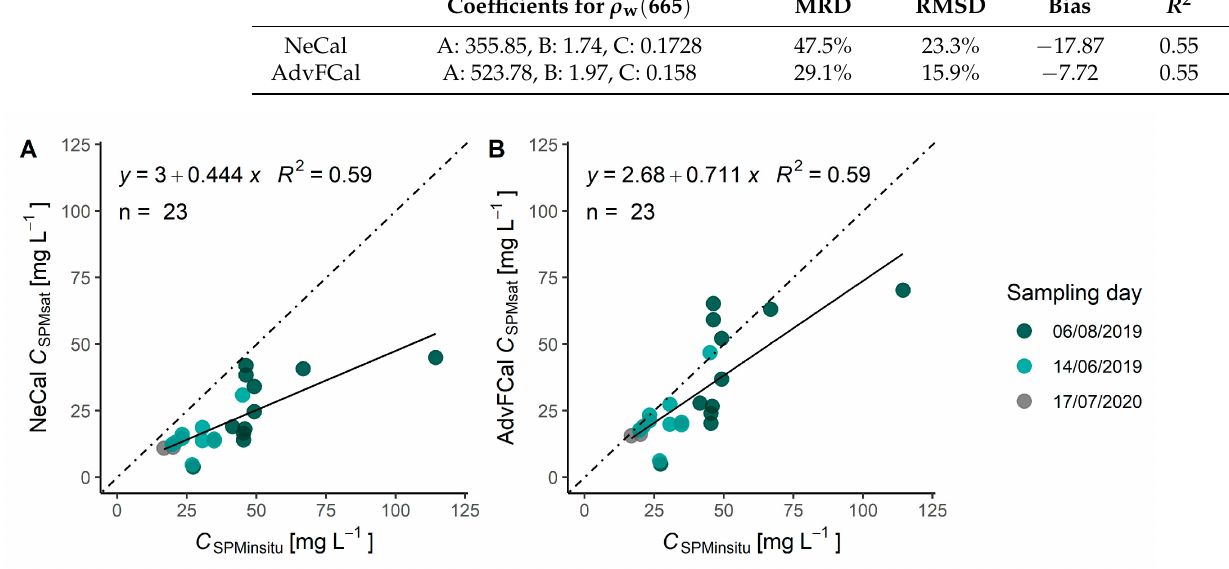
Figure 2. Validation comparison of ( A ) the original SPM algorithm calibration (NeCal) and ( B ) the regionally tuned algorithm (AdvFCal) based on the match-up dataset from three sampling days, shown by the different colours. The dashed line illustrates a 1:1 relationship between modelled and in-situ